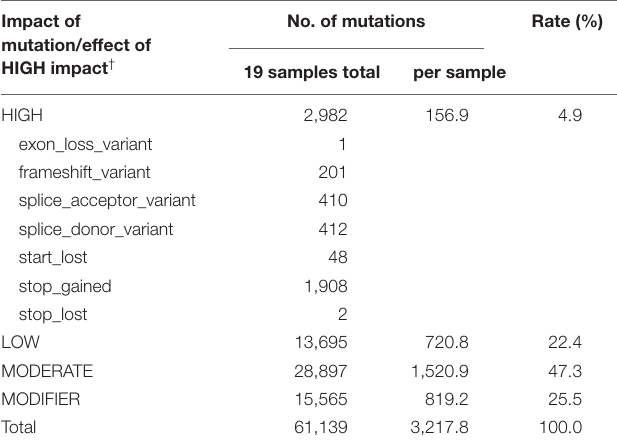
TABLE 1 | Impact of mutations detected in the target regions by whole-exome sequencing on the function of the gene products. Impact of mutation/effect